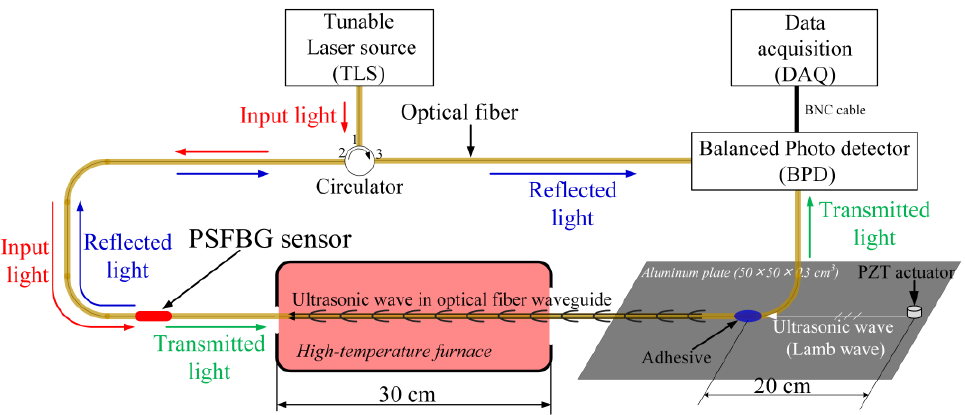
Figure 3. Ultrasonic detection using the optical fiber-waveguide in high temperature.